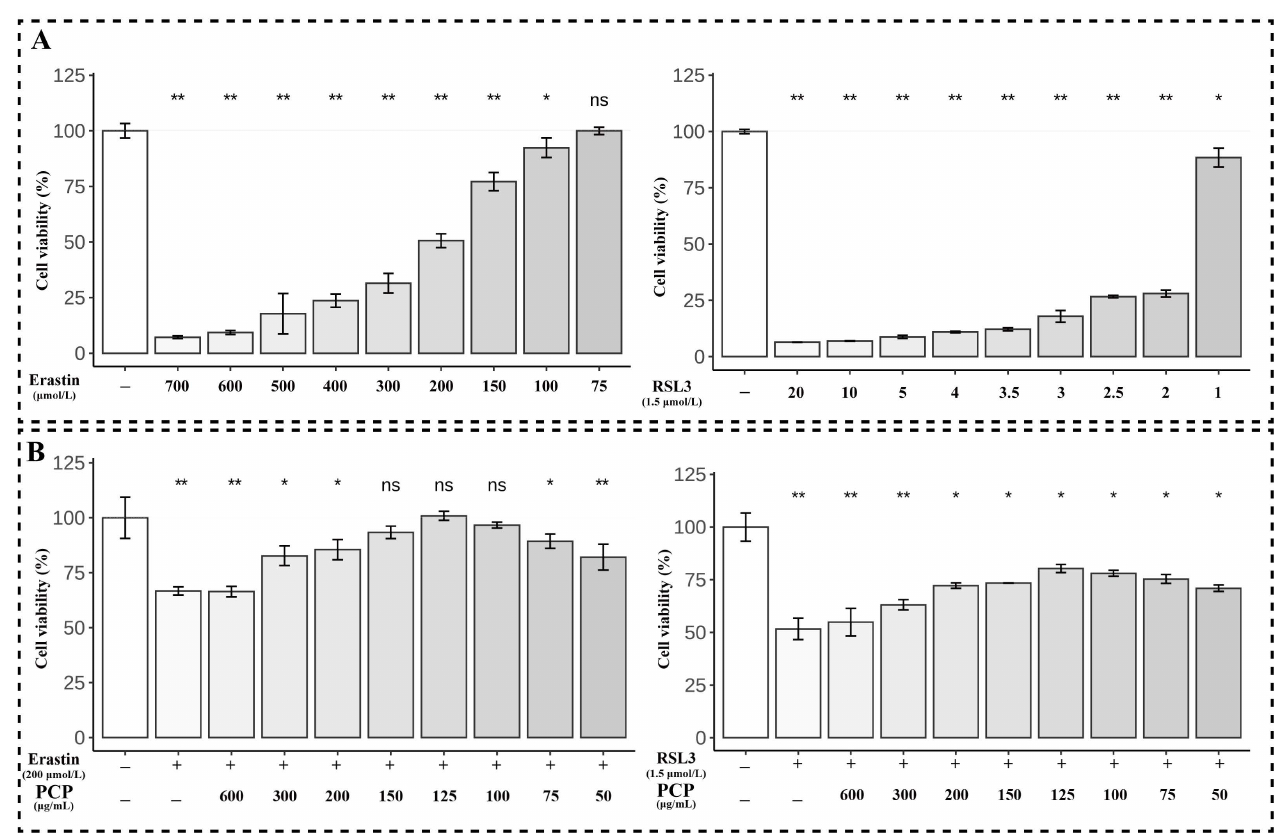
Figure 8. The cell viability in the microglia. The cells were treated using different concentrations of ERASTIN (0, 75, 100, 150, 200, 300, 400, 500, 600, and 700 µ mol) or RSL3 (0, 1, 2, 2.5, 3, 3.5, 4, 5, 10, and 20 µ mol) for 24 h, then treated with ERASTIN (200 µ mol)/RSL3 (1.5 µ mol) and PCP at different concentrations (0, 40, 60, 80, 100, 120, 150, 200, and 300 µ g/mL), determined by the CCK8 assay. The cell viability of microglia after using ERASTIN, the RSL3 treatment ( A ). The cell viability of microglia after using ERASTIN/RSL3 + PCP treatment ( B ). ( ns p > 0.05, * p < 0.05 and ** p < 0.01). 2.8. PCP Scavenged ERASTIN/RSL3 Induced Intracellular ROS in